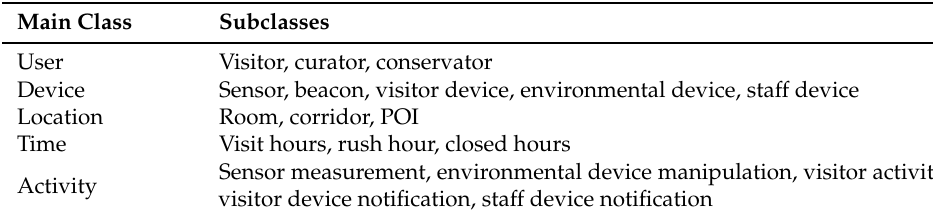
Table 4. Modeling the smart conservation.